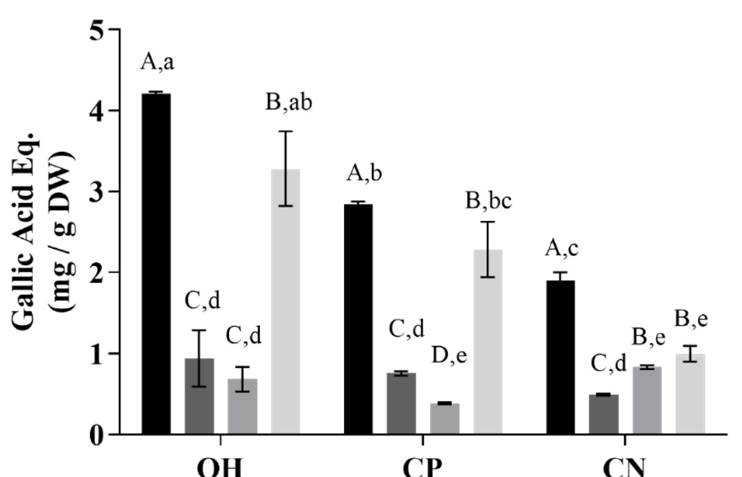
Figure 1. Total phenolic content of extracts performed with methanolic and aqueous solutions from grape wine-making by-products (gallic acid equivalent mg/g DW). OH—ohmic heating; CP—positive control; CN—negative control. Extraction solvents. ▪ MeOH with 1% HCl, ▪ H 2 O, ▪ lactic acid, ▪ citric acid. Different capital letters in the same extraction method indicate a statistically significant difference ( p < 0.01). The small letters represent statistical differences between solvents and extraction methods ( p < 0.05).